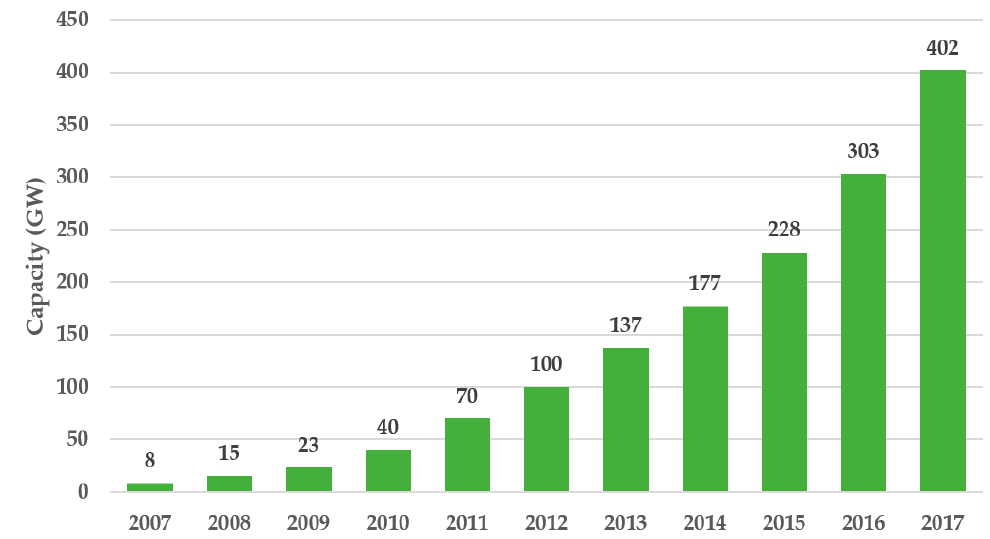
Figure 2. 2007–2017 global photovoltaic capacity (Data from [5]).